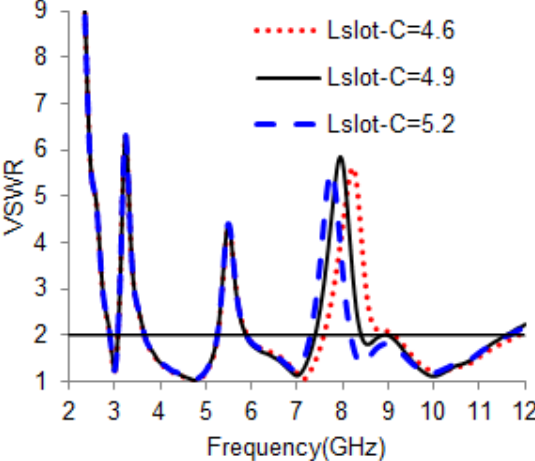
Figure 7: (c) VSWR curve for variation in length of slot-C for proposed Antenna-D.